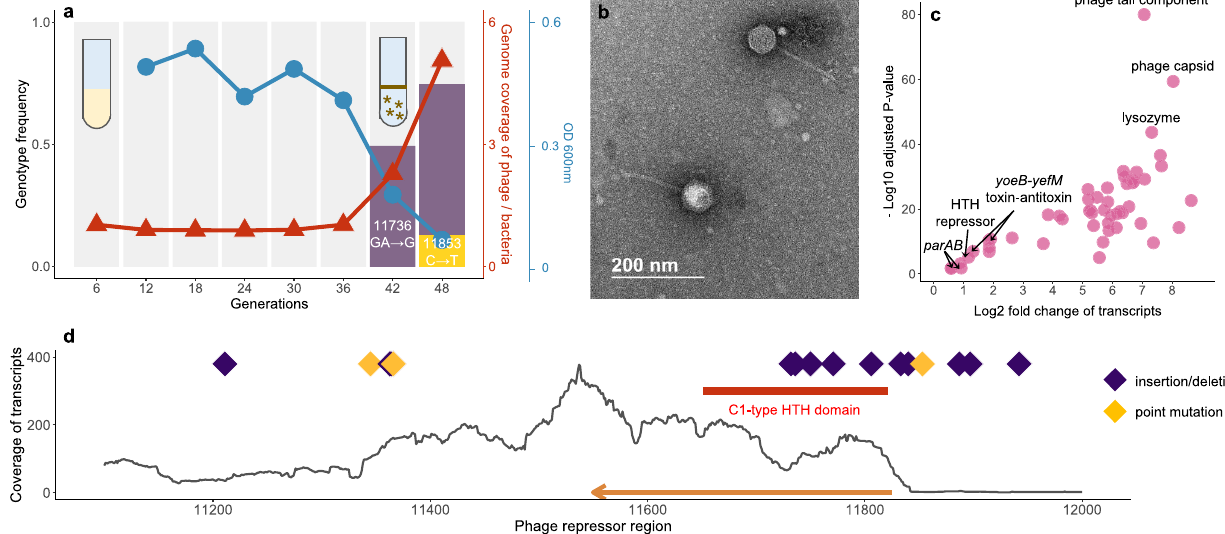
Fig. 1 | Mutations in a phage repressor region recurrently drives productive infection of the phage-plasmid. a Productive switch of a phage-plasmid in Trito- nibacter mobilis A3R06 was observed after ~40 generations of serial-dilution growth (red). A deletion mutation (11736: GA → G, purple bar) rapidly increased to ~50% relative genotypic frequency within one dilution cycle, before the increase sloweddowninthenextdilutioncycle.Asecondmutation(11853:C → T,yellowbar) was observed in the last dilution cycle. Planktonic bacterial culture became highly clumpy after the productive switch, as indicated by the sharp decrease in OD600 (blue). For eco-evolutionary trajectories for the other 8 populations temporally- trackedwithgenomicsequencing,seeFig.S4andTableS1. b Transmissionelectron microscopeimageofthephage-plasmidparticle.Imagingwasperformedforseven timeswithbiologicaltriplicates,allyieldingsimilarresults. c